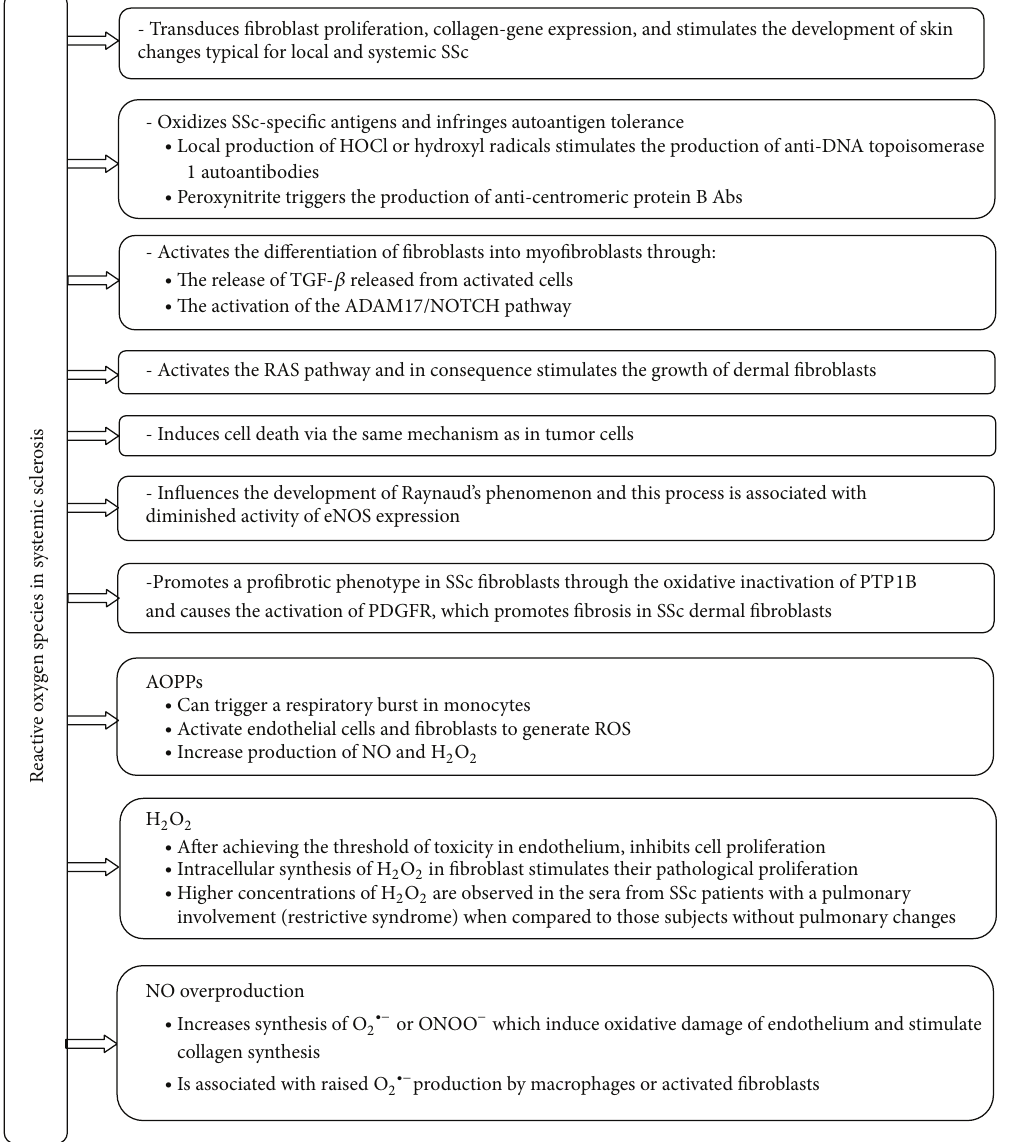
Figure 2: The role of oxidative stress in systemic sclerosis. HOCl: hypochlorous acid; TGF- 𝛽 : transforming growth factor 𝛽 ; ADAM17/NOTCH: ADAM17 (disintegrin and metalloproteinase domain-containing protein 17; also known as TACE) involved in the activation of the Notch signaling pathway; Ras proteins: a family of related proteins involved in transmitting signals within cells through the Ras pathway and belonging to a class of proteins called small GTPase; eNOS: endothelial nitric oxide synthase (eNOS or NOS3); PTP1B: protein tyrosine phosphatases 1B; PDGFR: platelet-derived growth factor receptor; AOPPs: advance oxidation protein products; NO: nitric oxide; H 2 O 2 : hydrogen peroxide; O 2∙− : superoxide anions; ONOO − : peroxynitrite.